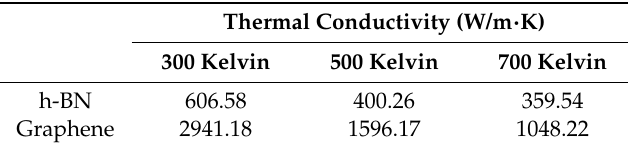
The obtained temperature dependent results of thermal conductivity in h-BN and Graphene